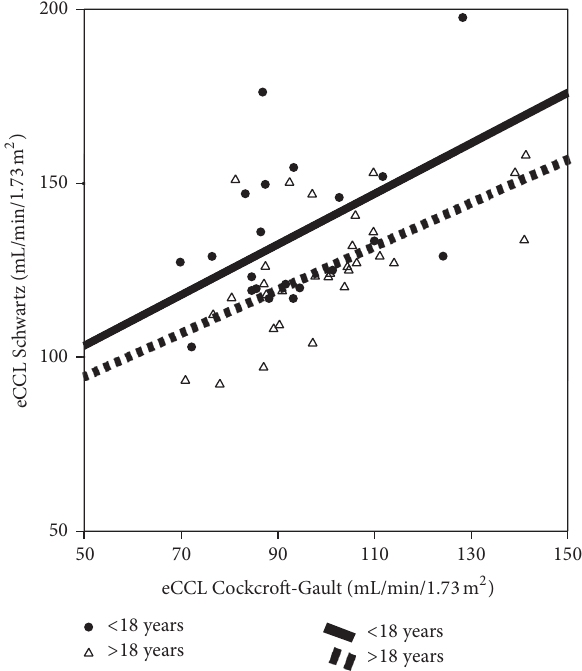
Figure 1: Correlation of estimated creatinine clearance (eCCL) calculated by the formula of Cockcroft-Gault versus formula by Schwartz ( e = CF patients < 18 years, △ = CF patients > 18